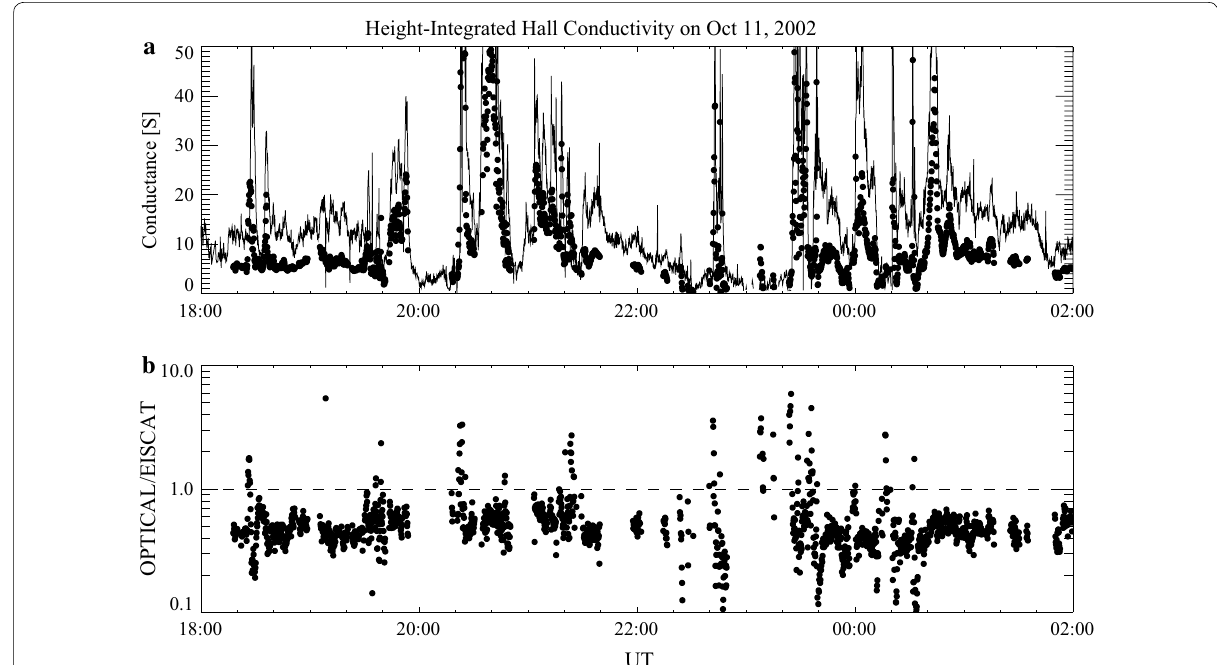
Fig. 10 Comparison of Hall conductivities for October 12, 2002; the same as Fig. 8 except for the height-integrated Hall conductivities